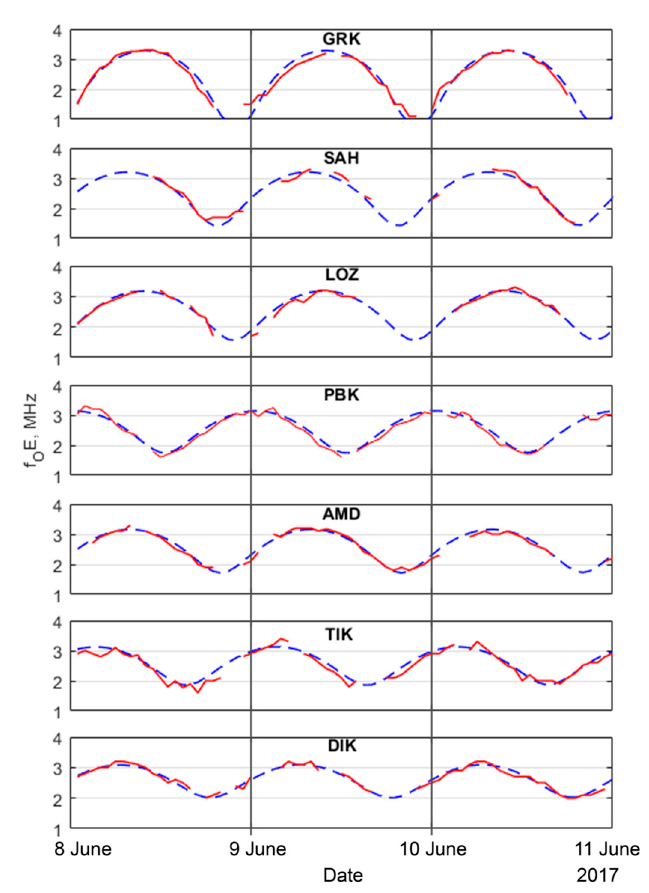
Figure 2. Diurnal variation of the ionosphere regular E region critical frequencies determined by high-latitude observatories Gorkovskaya (GRK), Salekhard (SAH), Lovozero (LOZ), Pevek (PBK), Amderma (AMD), Tiksi (TIK), and Dickson (DIK) (red lines), and critical frequencies calculated using the AIM-E model with EUVAC model photon flux input (blue dashed lines) for the period of 8–10 June 2017.